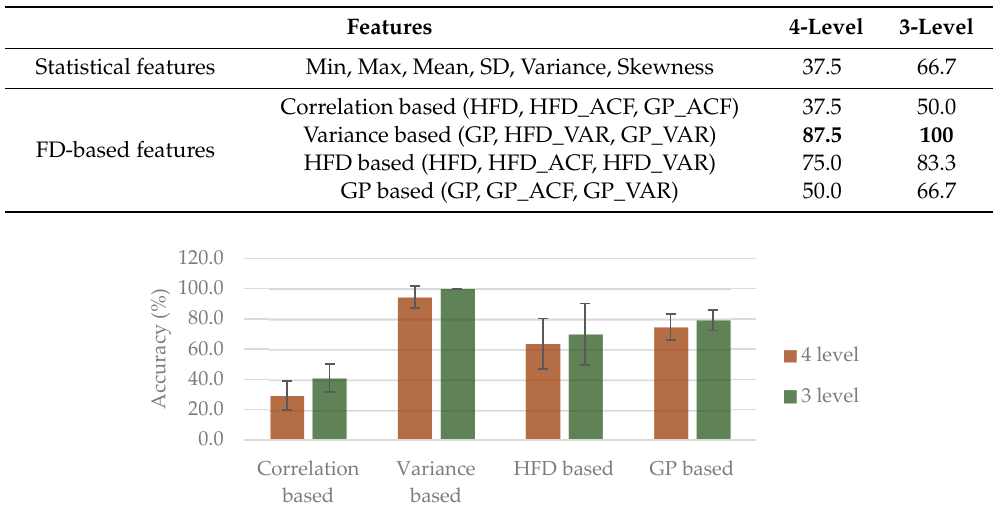
Table 6. Comparison of classification accuracy (%) between combined statistical features and FD-based combined features manually grouped. The highest accuracy is shown in bold.